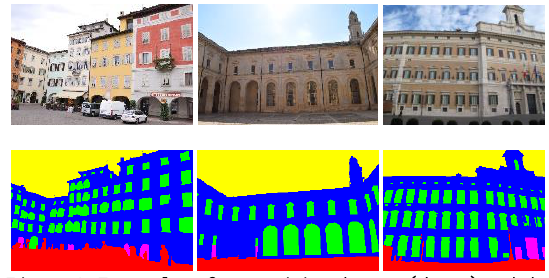
Figure 4: Examples of our training dataset (above) and the corresponding manually labelled images (below). The classes correspond to the following colors: “sky”=yellow, “building” = blue, “window”=green and “obstacle”=red.